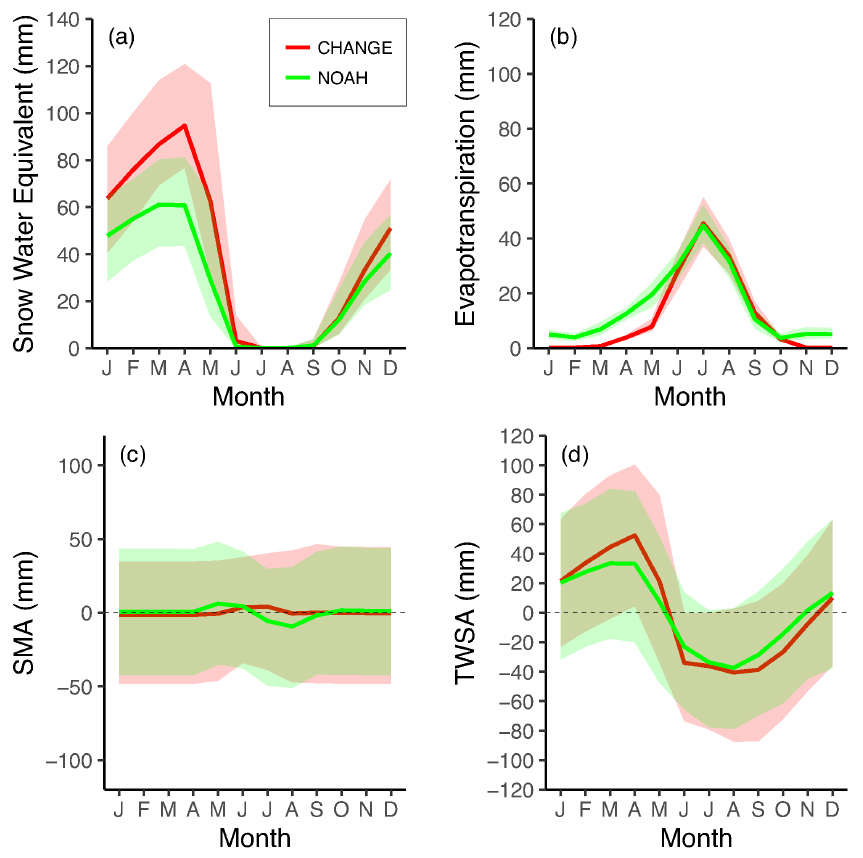
Figure 5. Seasonal variations in monthly climatology in hydrometeorological variables derived from CHANGE and NOAH model simulations from 1979 to 2012. The shaded area denotes the 95% confidence interval (CI): ( a ) Snow water equivalent, ( b ) Evapotranspiration, ( c ) soil moisture anomaly (SMA), and ( d ) terrestrial water storage anomaly